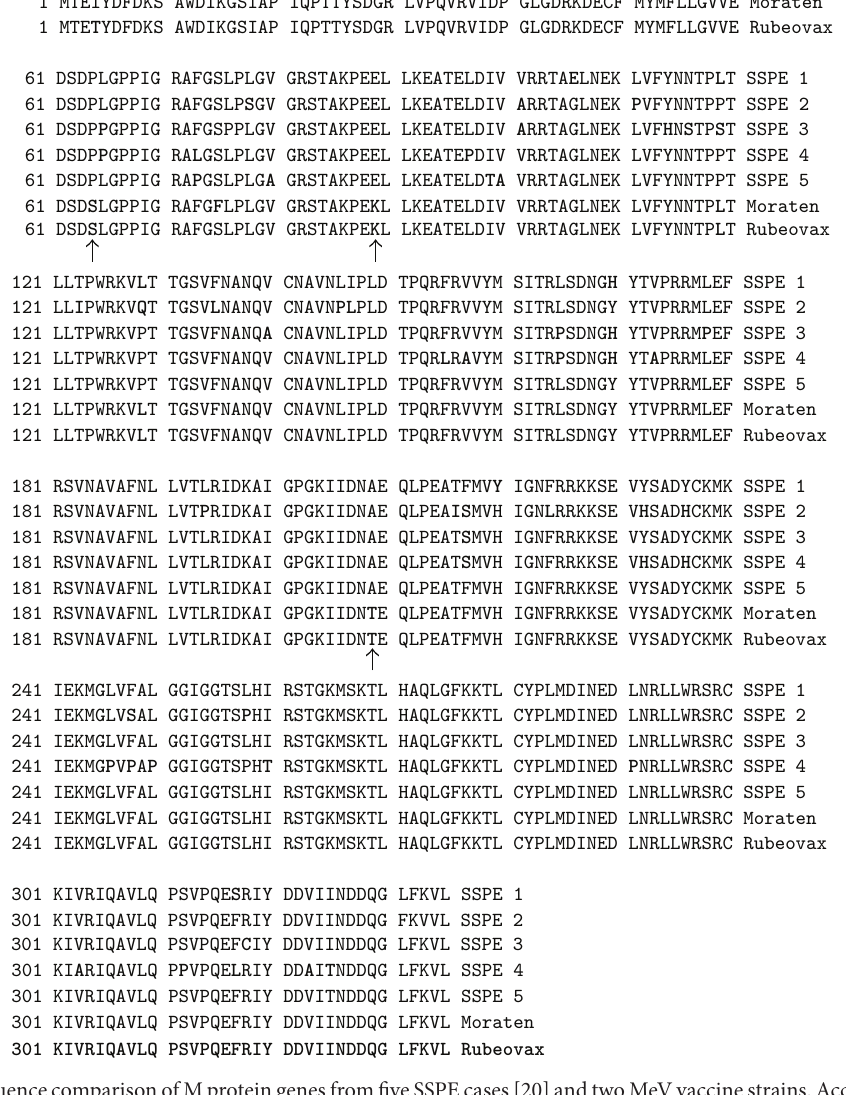
SKT is involved, at least in part, in loss of